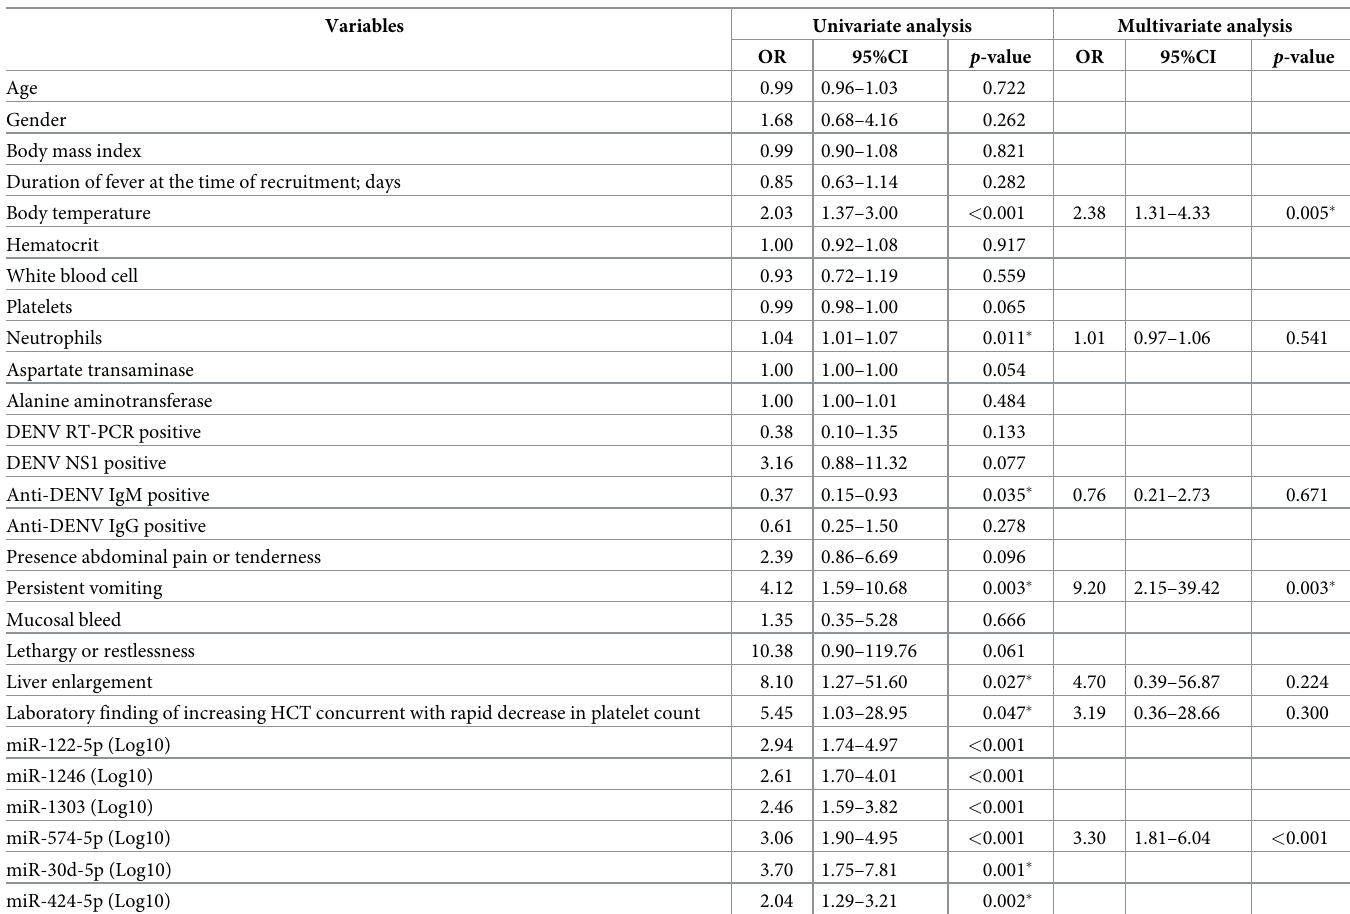
Table 4. Variables associated with severe